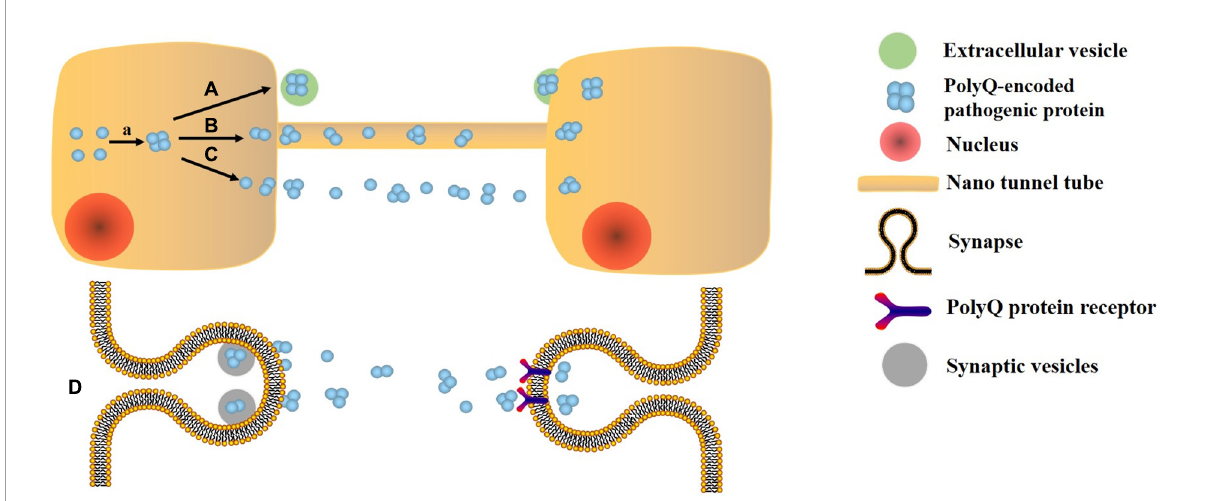
FIGURE1 Transmission mechanism of polyQ protein. a. Error folding and aggregation of polyQ encoded protein. A. Extracellular vesicle pathway. B. Nano tunnel tube approach: the polyQ protein is exchanged by a tunnel-like membrane-derived structure that connects two cells. C. Soluble oligomer: due to its high solubility and small size, PolyQ protein may be able to escape from cells and diffuse to other cells. D. Synaptic connection: the polyQ protein is transmitted between neurons with high transmission